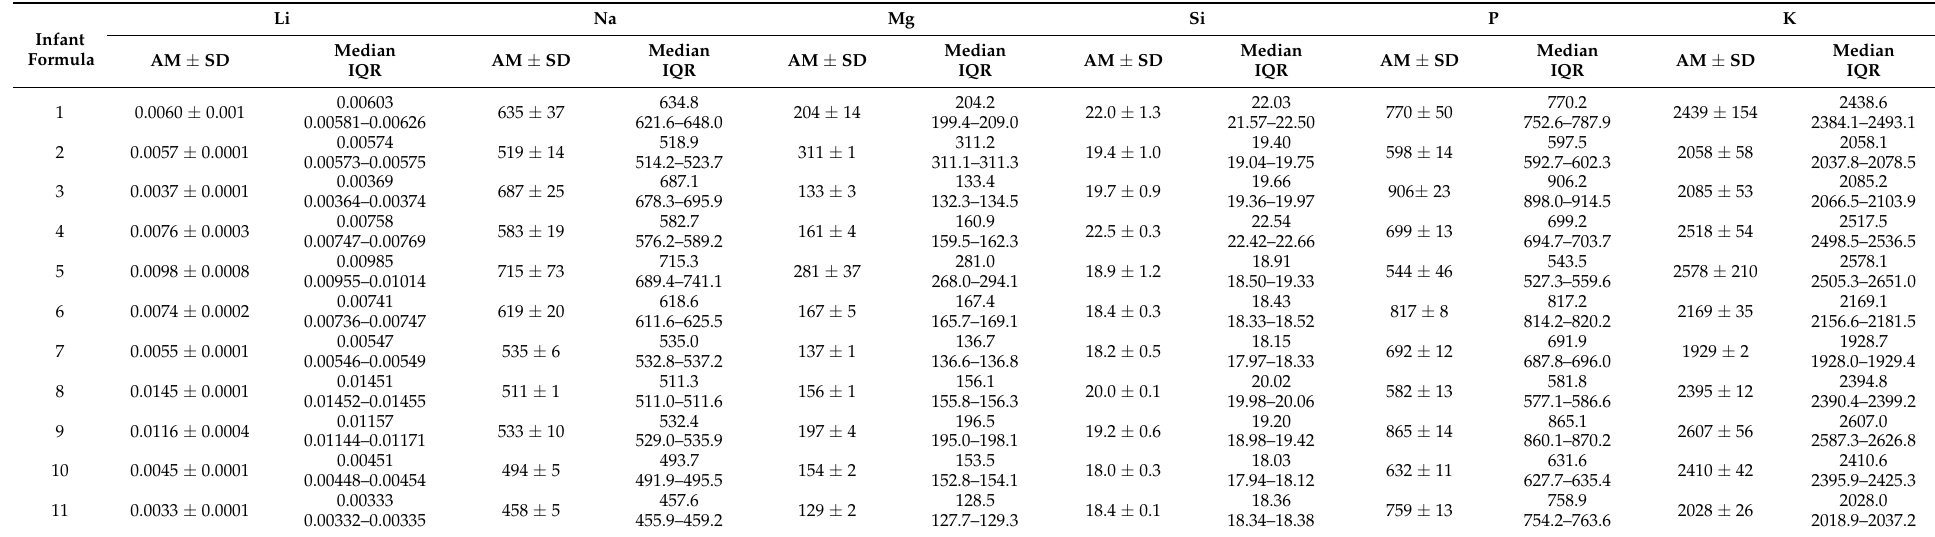
Table 2. Descriptive statistics of Li, Na, Mg, Si, P and K calculated on a total of 12 determinations for each formula and expressed as µ g g − 1 .